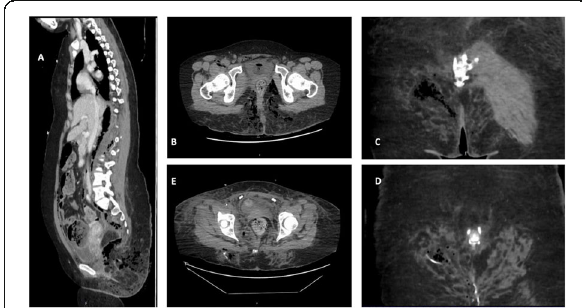
A105. Use of an innovative cuff pressure control and subglottic secretions drainage system in COVID-19 ARDS patients undergoing